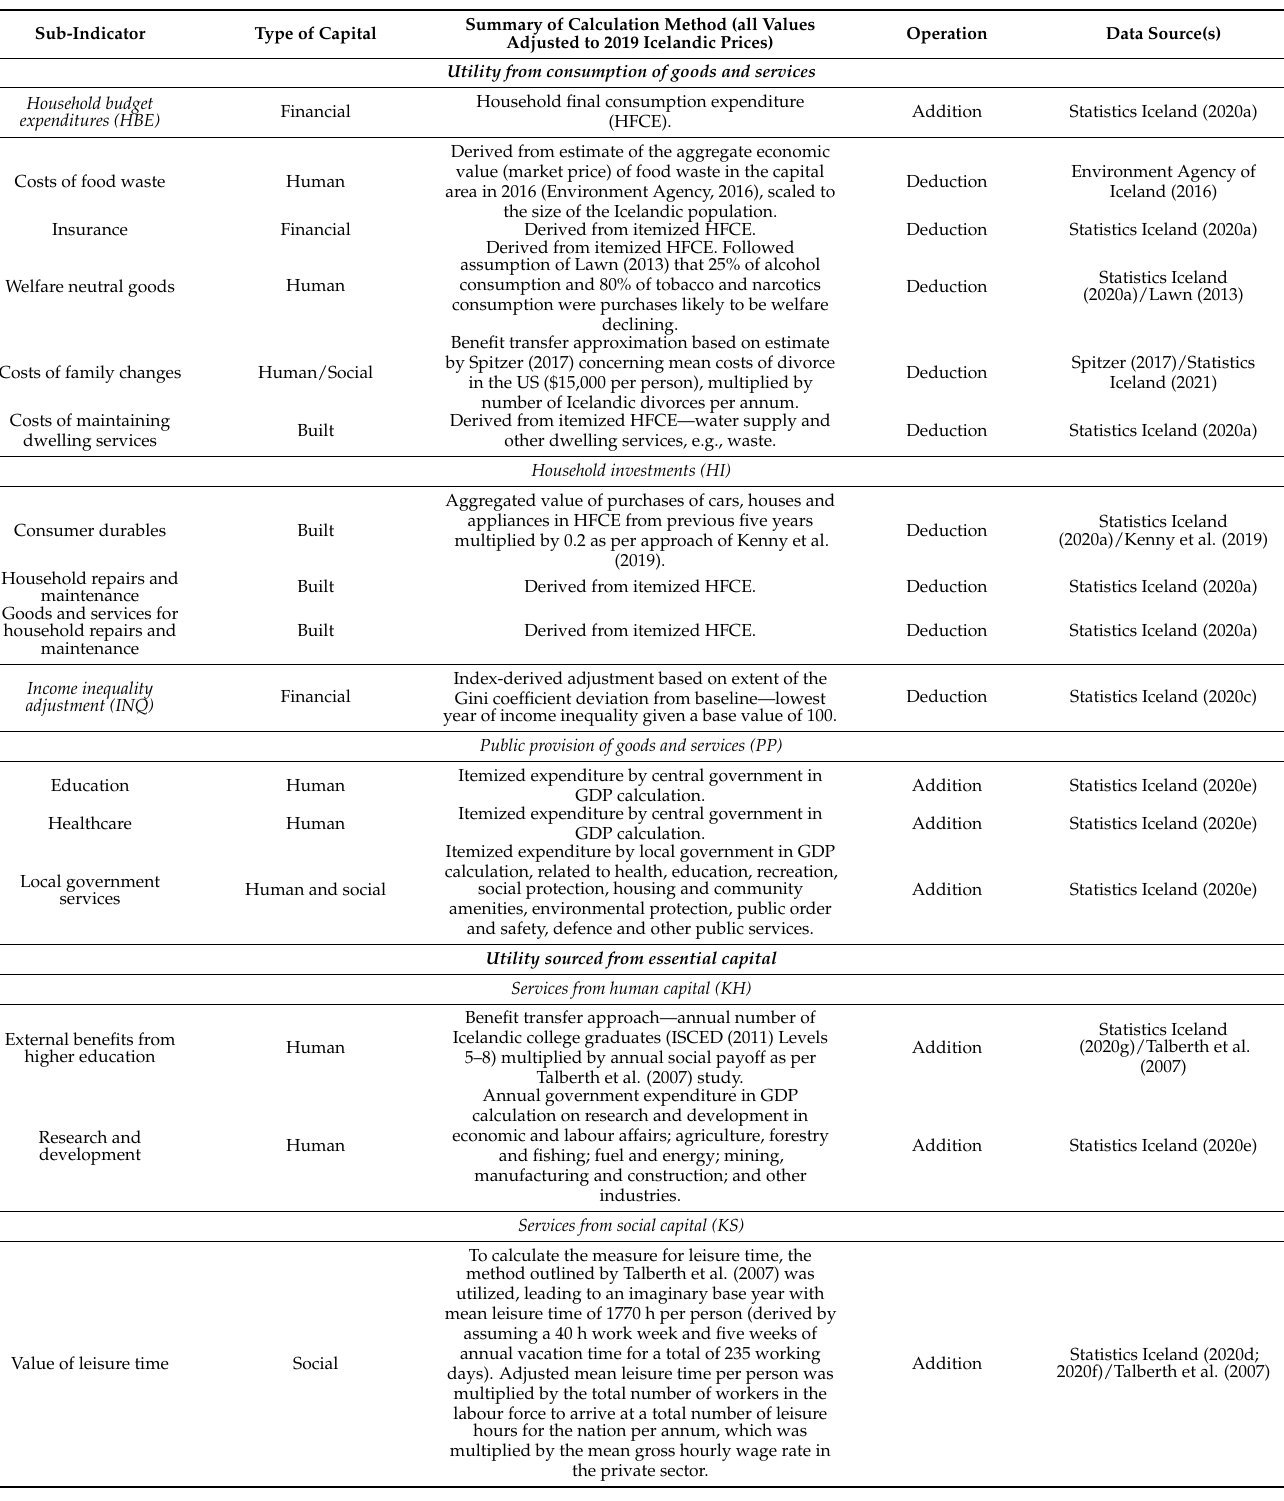
Table A1. Detailed methodology used in the calculation of Iceland’s GPI (Reprinted with permission from ref. [34]. Copyright 2021